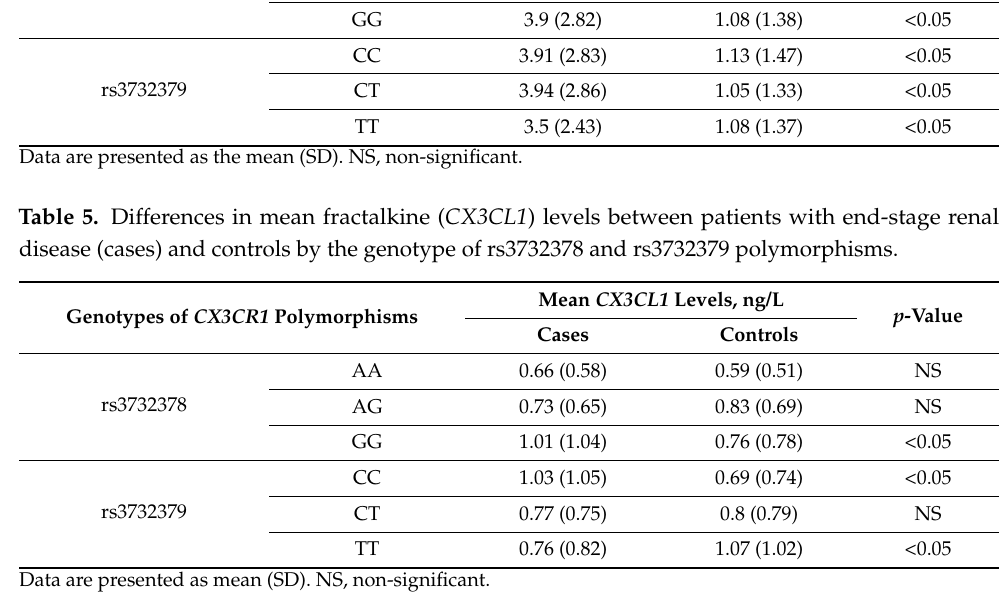
Table 6. Differences in the mean fractalkine receptor ( CX3CR1 ) levels between patients with end-stage renal disease (cases) and controls by the genotype of rs3732378 and rs3732379 polymorphisms. Genotypes of CX3CR1 Polymorphisms